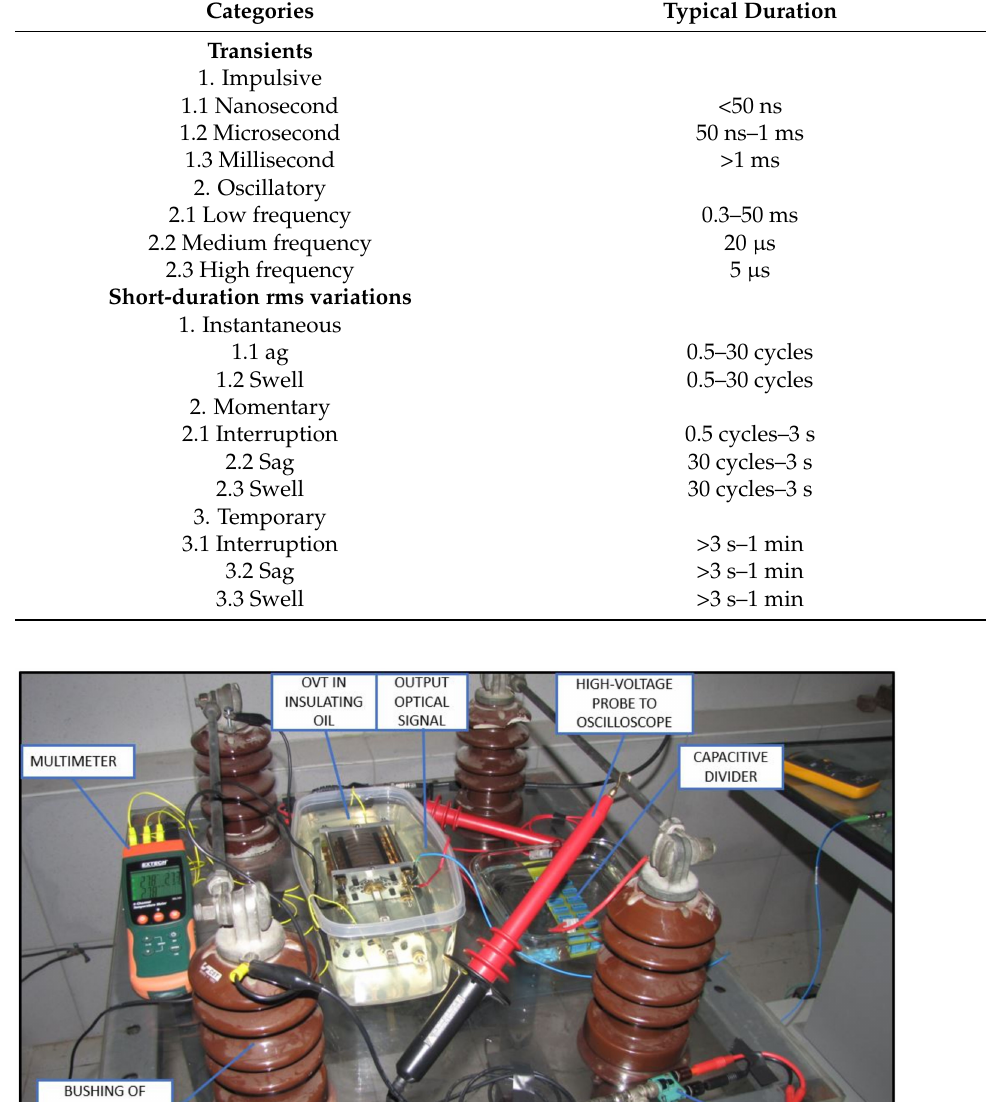
Table 2. Categories and typical characteristics of power system phenomena according to the IEEE 1159-2019 standard [1].